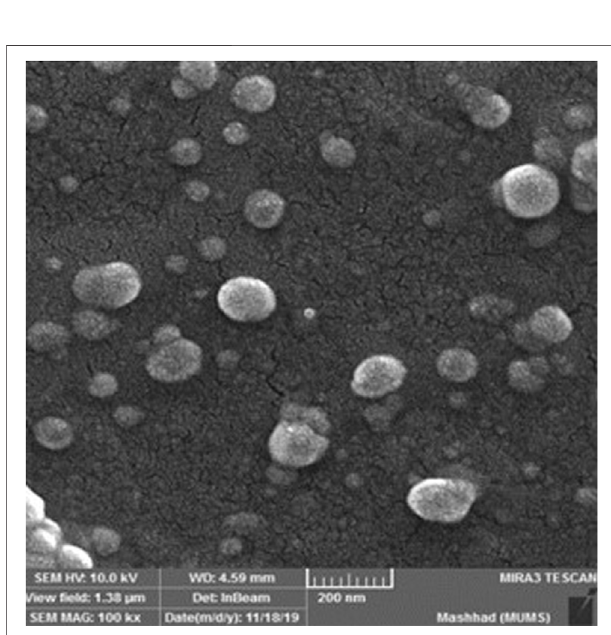
FIGURE2| TheFESEManalysisof Achilleamillefolium phenolics-loaded nanoliposomes.